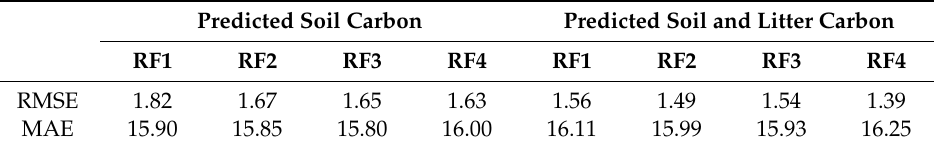
Table 5. Root mean square error (RMSE) and mean absolute error (MAE)of the four random forest (RF) models using the validation data (unit: t C ha − 1